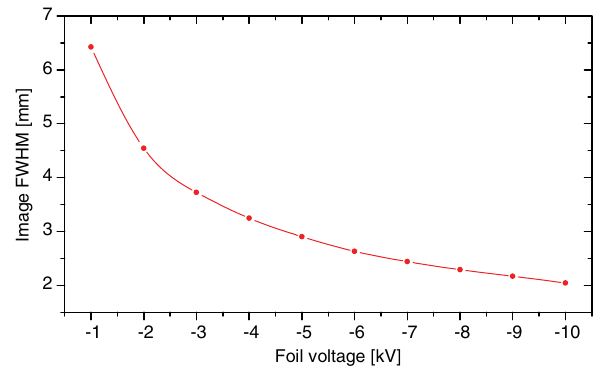
FIG. 5. Simulated FWHM of the images recorded at the MCP surface as a function of voltage applied to the